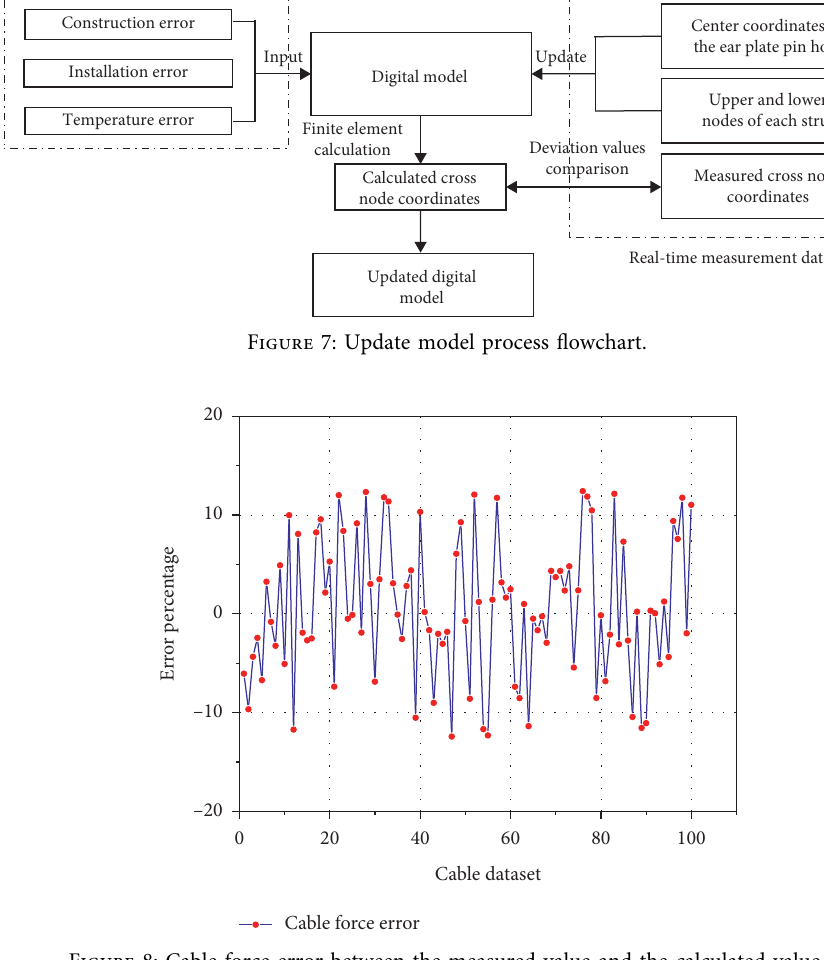
Figure 8: Cable force error between the measured value and the calculated